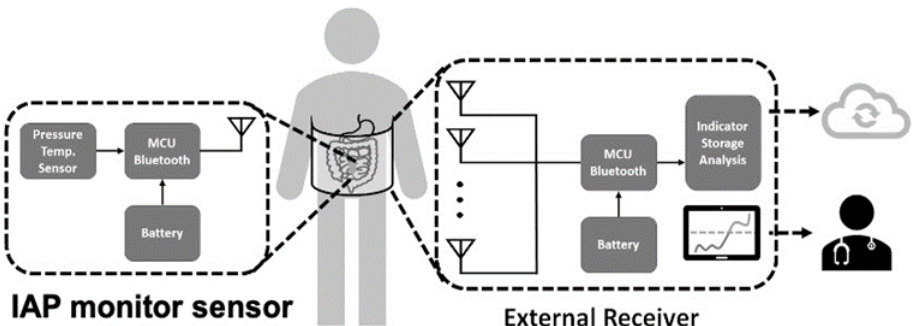
Figure 6. Schematic of wireless intra-abdominal pressure-monitoring sensor platform that can deliver information to clinical healthcare providers and cloud-based databases.